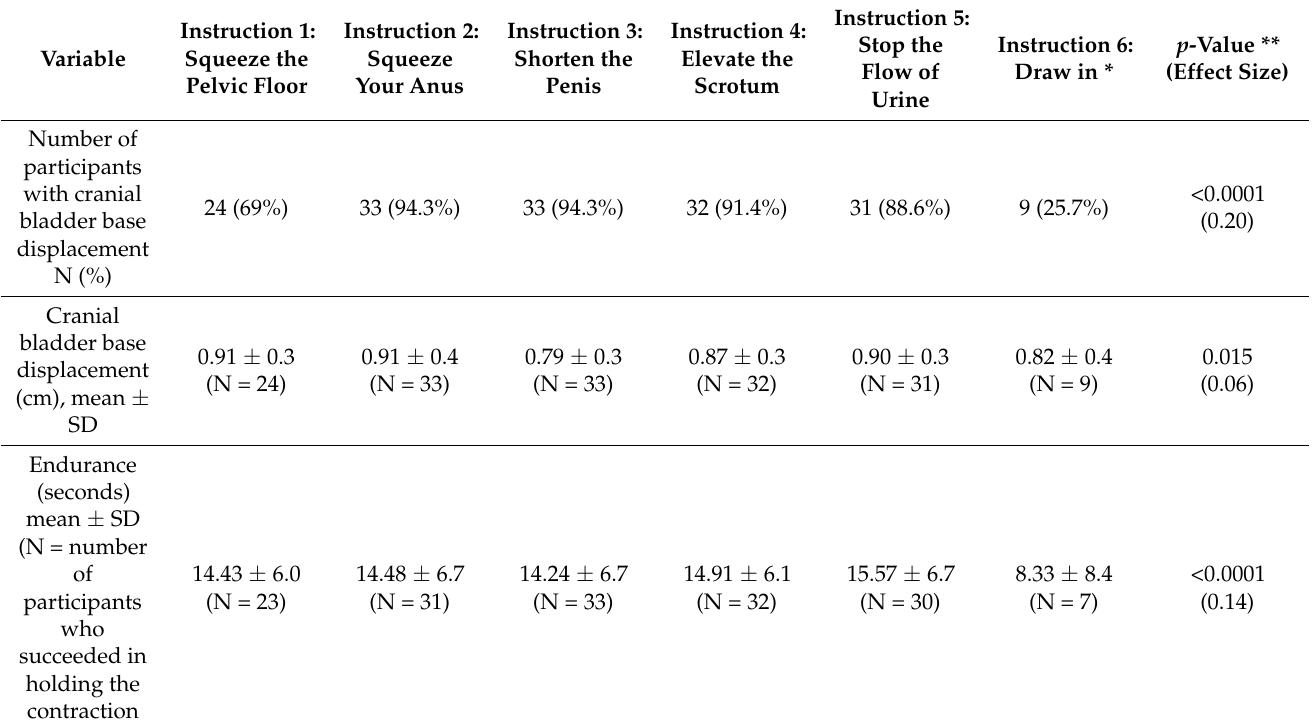
Table 2. Differences in mean cranial displacement (cm) of the bladder base and muscle endurance between 6